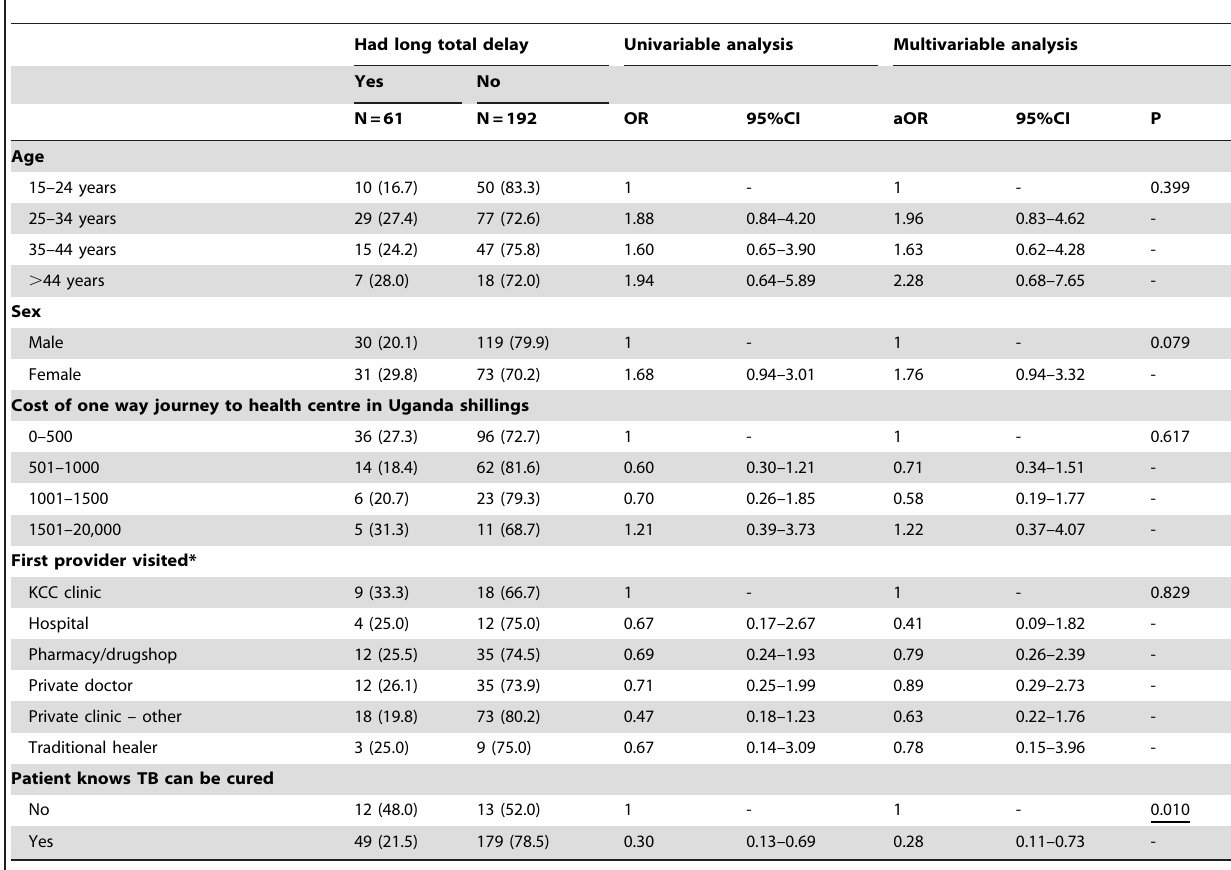
Table 2. Long total delay and predictor variables of 253 smear-positive pulmonary tuberculosis patients registered for treatment at three Kampala City clinics, Uganda